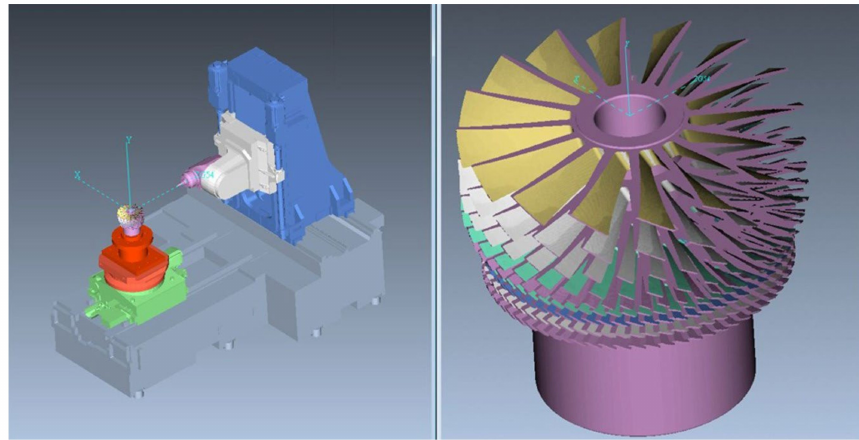
Figure 8. Verification of solid model cutting simulation.